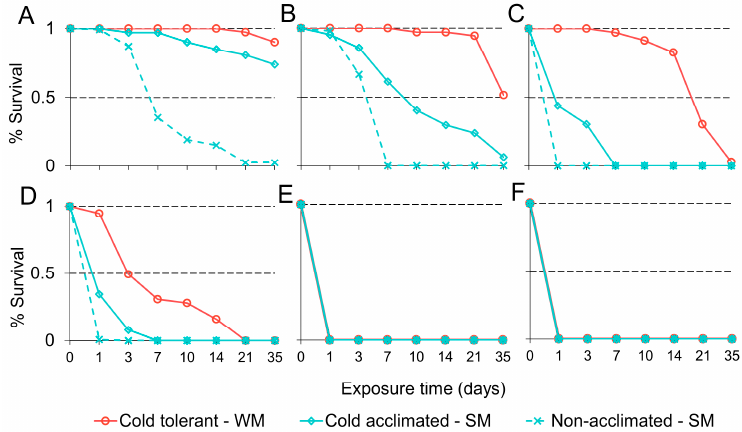
Figure 3. Mean percent survival (y-axis) of adult D. suzukii with varying states of cold hardiness in response to 4.4 ( A ), 1.67 ( B ), − 1.11 ( C ), − 3.87 ( D ), − 6.67 ( E ), or − 9.4 °C ( F ) chronic cold exposure for up to 35 days (x-axis). Line color indicates cold-hardiness treatment group: developmentally acclimated WM flies (solid red line), cold-acclimated SM flies (solid blue line), and non-acclimated SM flies (dashed blue line).